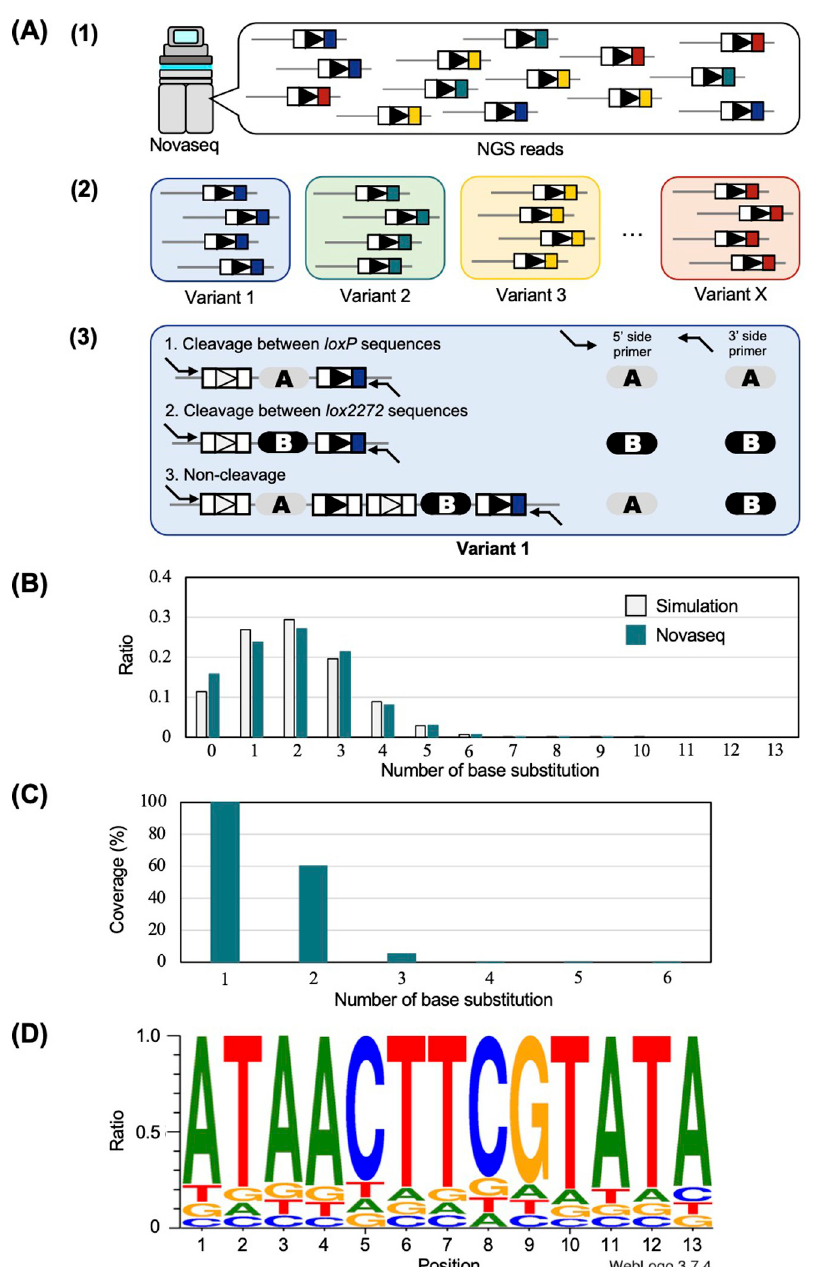
Fig 4. Analysis of the cleavage rate of loxP variants by Novaseq. (A) Schematic overview of the Illumina sequencing analysis. We analyzed the Illumina sequencing data in three steps. (1) We extracted DNA sequences that possessed sequences of loxP variants. (2) All paired-end Illumina sequencing reads were classified according to the type of mutation in loxP sequences. (3) Using the paired-end Illumina sequencing reads obtained using the primer at the 5 0 side and the primer at the 3 0 side, we identified the patterns of recombination of Illumina sequencing reads for each loxP variant. If an Illumina sequencing read possessed sequence A, we determined that the plasmid was cleaved between loxP sequences by Cre. If an Illumina sequencing read possessed sequence B, we determined that the plasmid was cleaved between lox2272 sequences by Cre. If an Illumina sequencing read possessed sequences A and B, we determined that the plasmid was not cleaved. (B) Comparison of the distribution of the number of substituted bases between experimental values and theoretical values. The light-gray color indicates the theoretical values (substitution rate = 15.3%). Green indicates the experimental value. This method of calculation is provided in the Materials and Methods. (C) Coverage rate (%) of substitution. (D) Nucleotide rate at each position of loxP sequences.